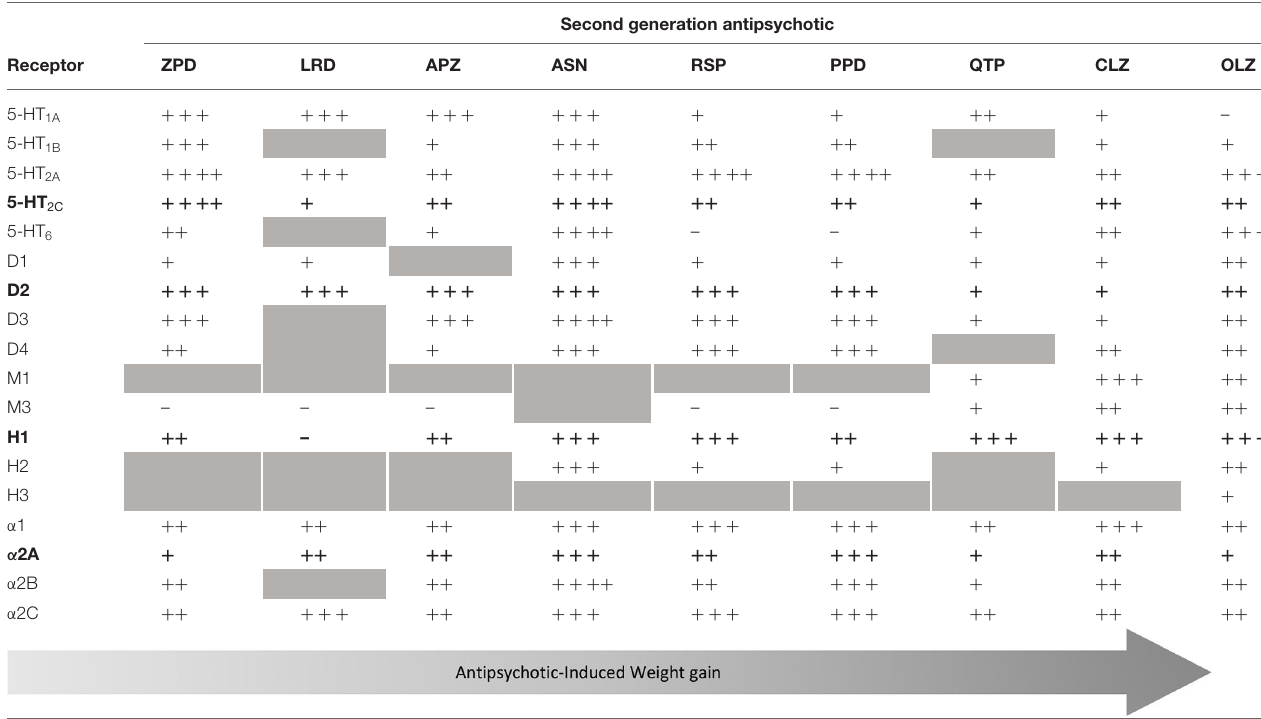
TABLE 1 | Second generation antipsychotic neurotransmitter receptor binding profiles.